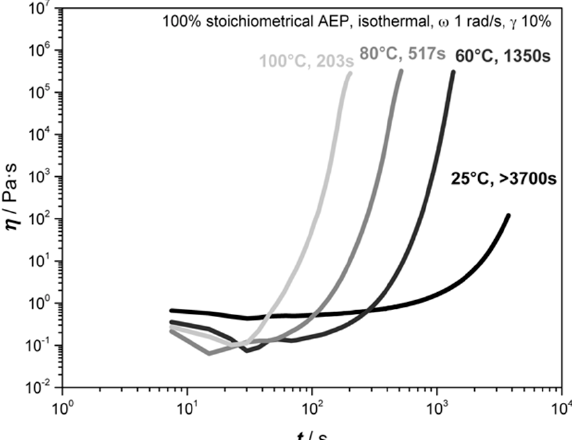
Figure 4. Rheological investigations of DGEBA with a stoichiometric amount of AEP at different isothermal temperatures.